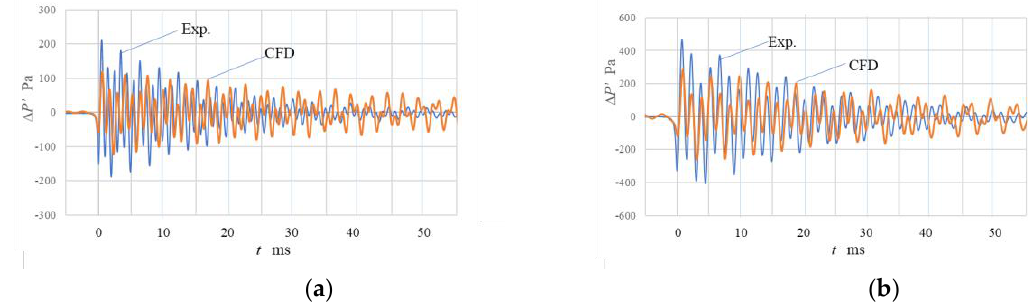
Figure 9. Comparison of pressure profile at the position of the hydrophone. ( a ) φ = 6 mm. ( b ) φ = 10 mm.